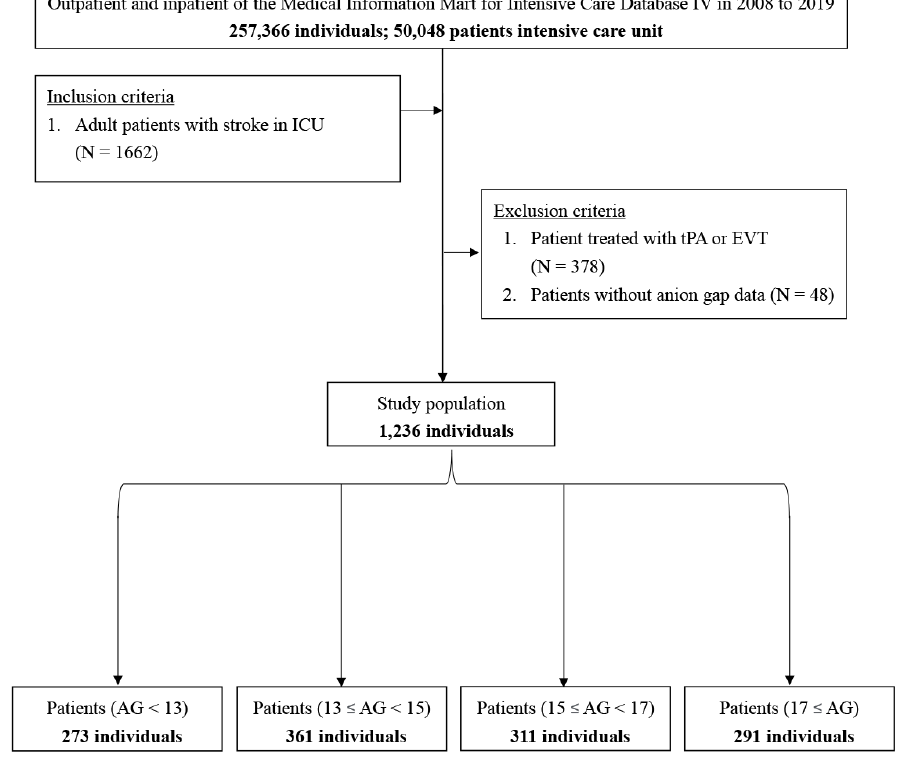
Figure 1. Flowchart of study patients.